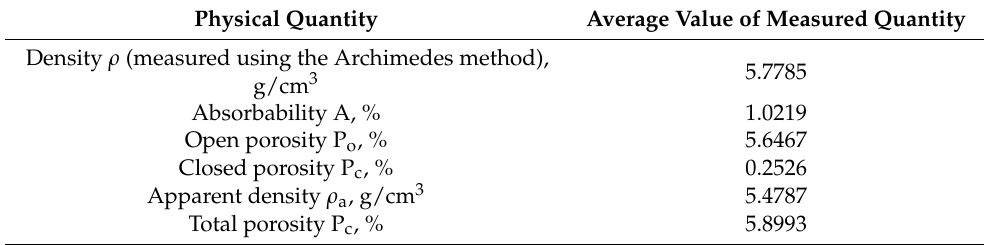
Table 5. Results of the µ CT analysis and calculations concerning the surface layer (PPTAW